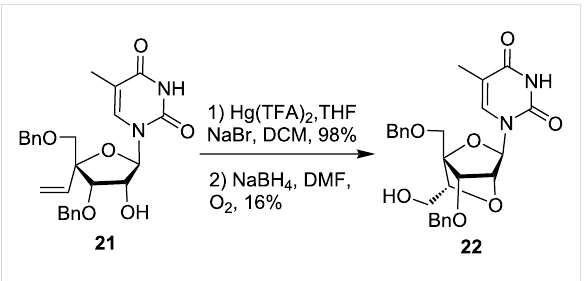
Scheme 10: Synthesis of Hg(TFA) 2 -mediated bicyclic nucleoside de-